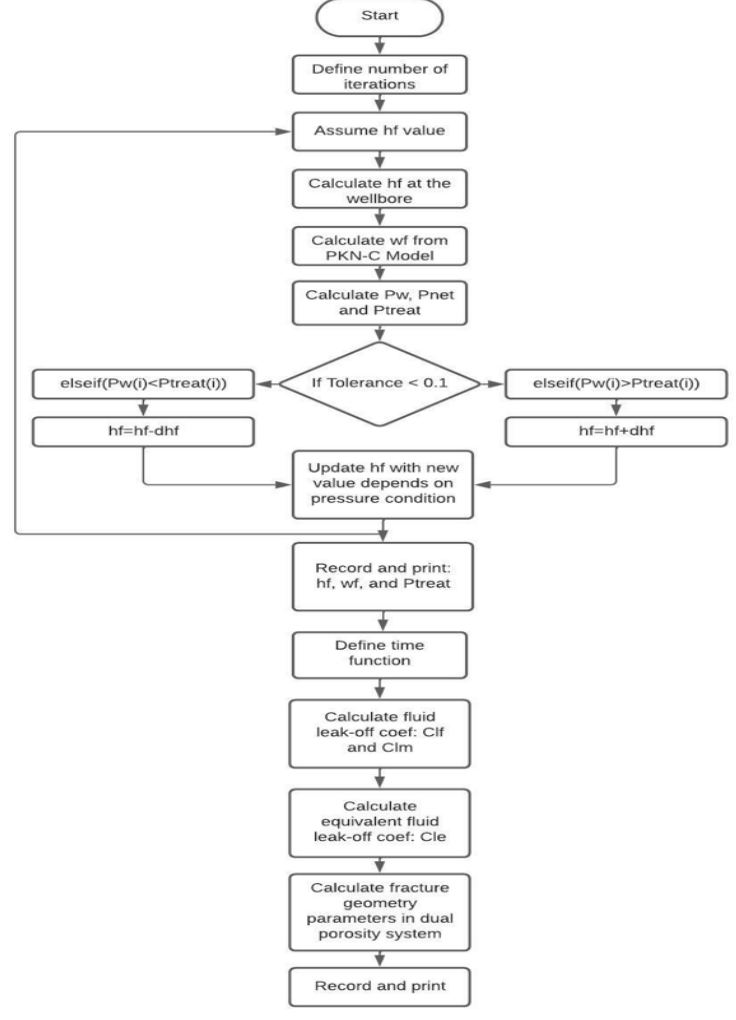
Figure 2. Algorithm for the P3D-C-DP model. Table 1. Input parameters for model